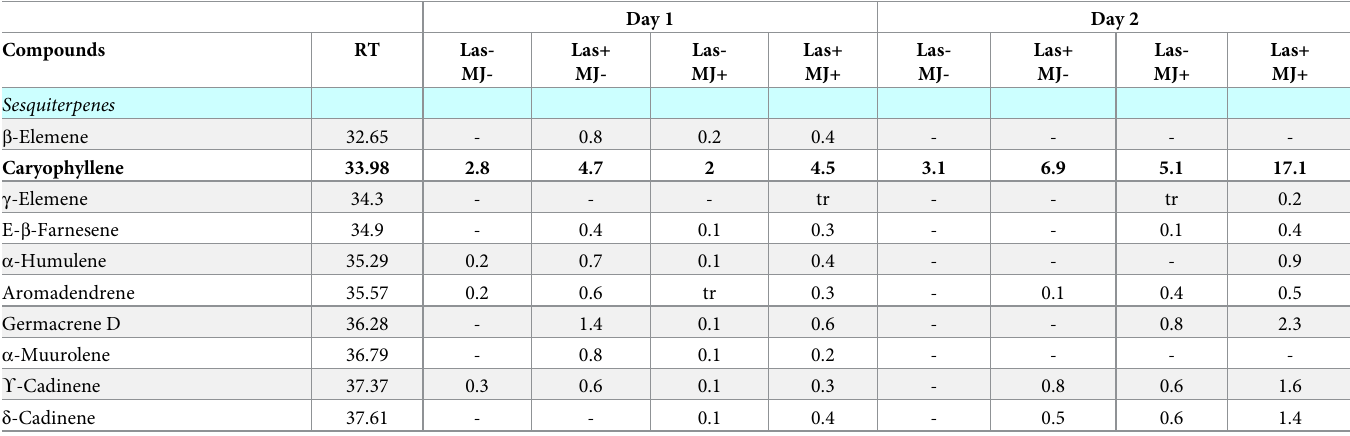
Abbreviations of treatment names: Las- = uninfected, Las+ = infected, MJ+ = treated with methyl jasmonate, MJ- = control. Volatiles are listed according to chemical class and within class according to retention time. Tr = compounds that comprise < 0.1% of the total amount of each treatment. (cid:3) Values with different letters within each collection day are different at P (cid:20) 0.0125, planned t-test comparisons. Compounds marked in bold are responsible for 50% of the differences observed between treatments (SIMPER similarity percentage breakdown